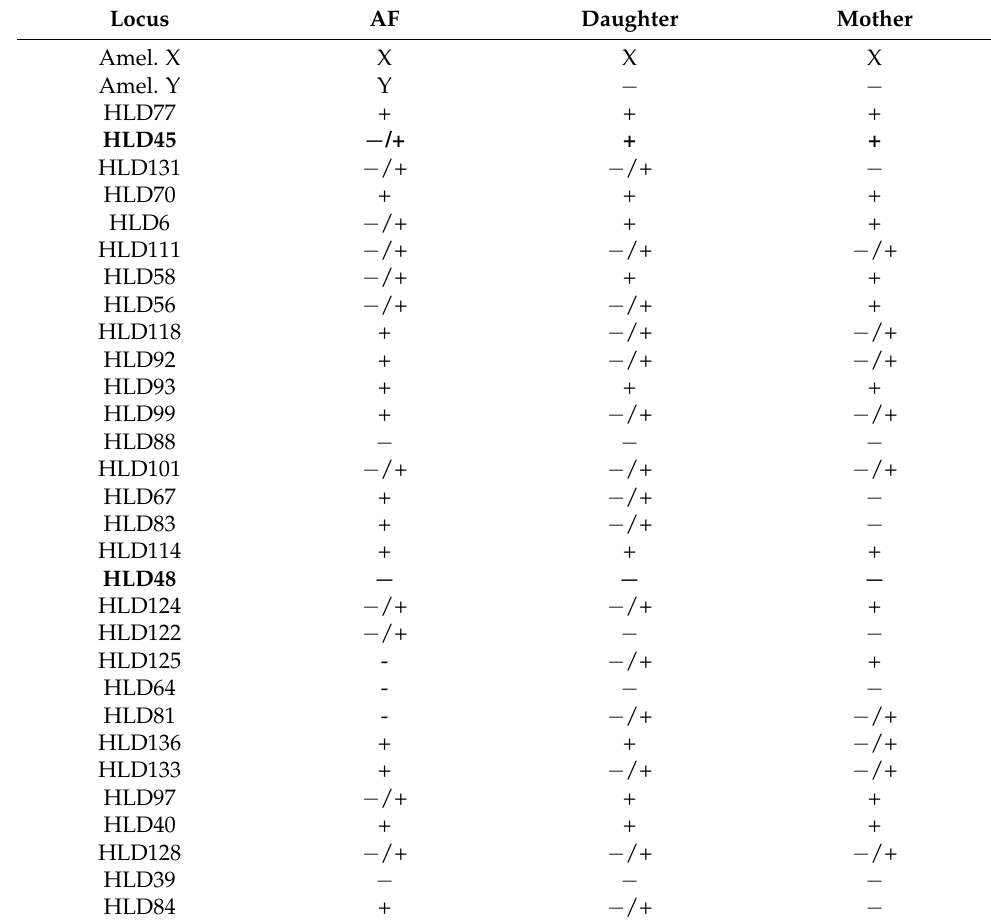
Table A3. Summary of obtained insertion–deletion (in-del) genotypes using DIPplex (AF—alleged father). The two bolded loci are located at chromosome